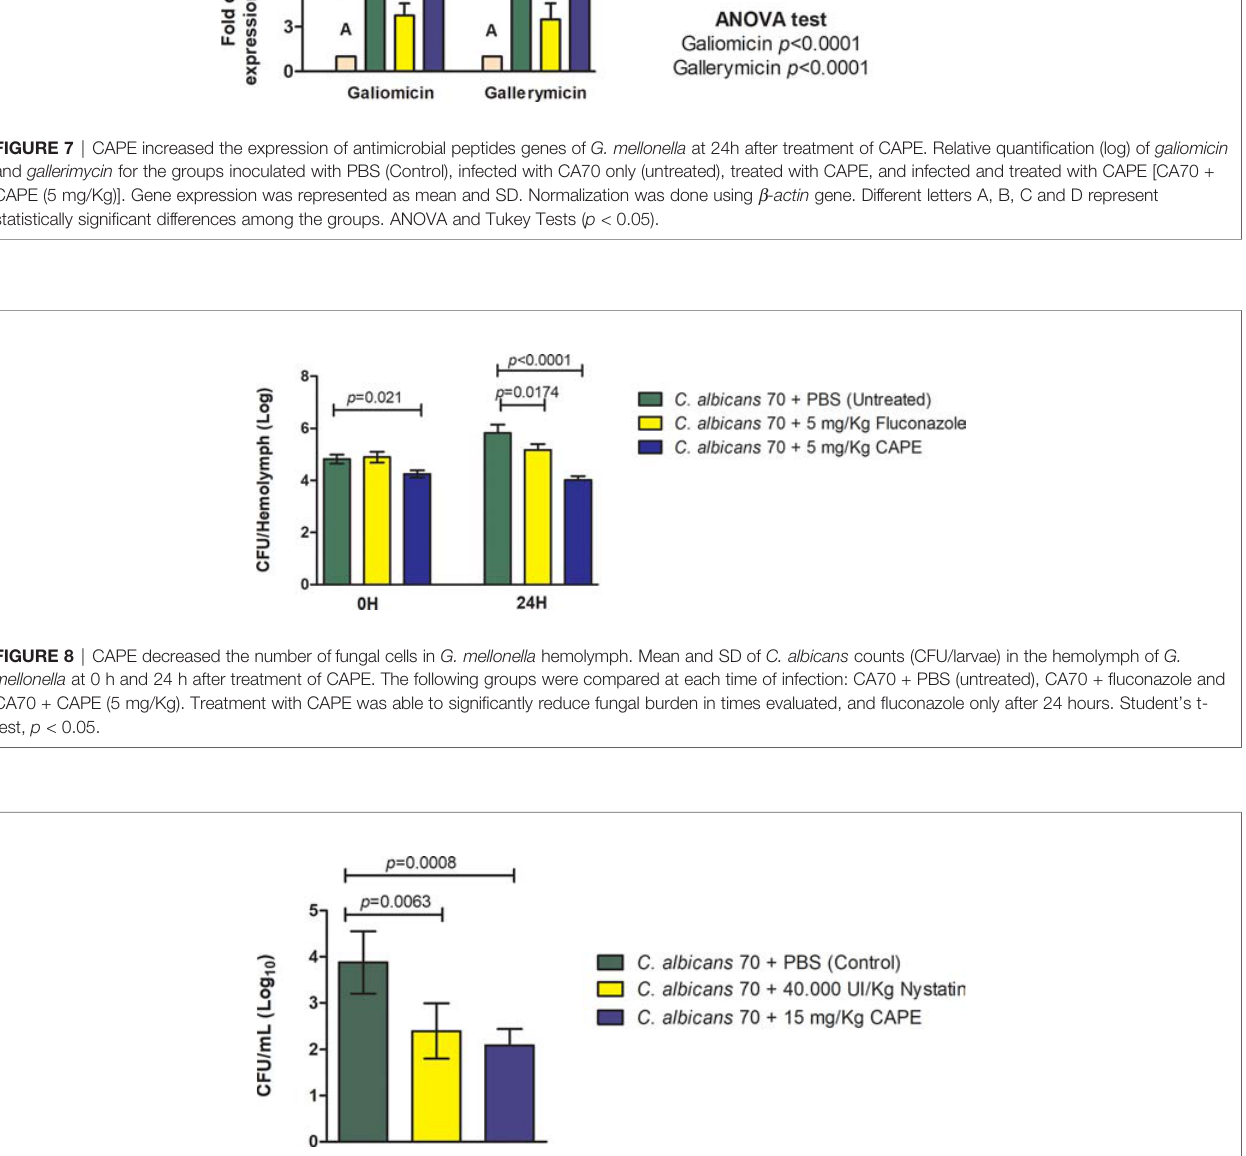
FIGURE 9 | Recovery of C. albicans from the oral cavity of mice. C. albicans CFU/mL recovered from the oral cavity of mice infected by CA70 and treated with PBS (control group), with nystatin and CAPE (Student ’ s t test, p <